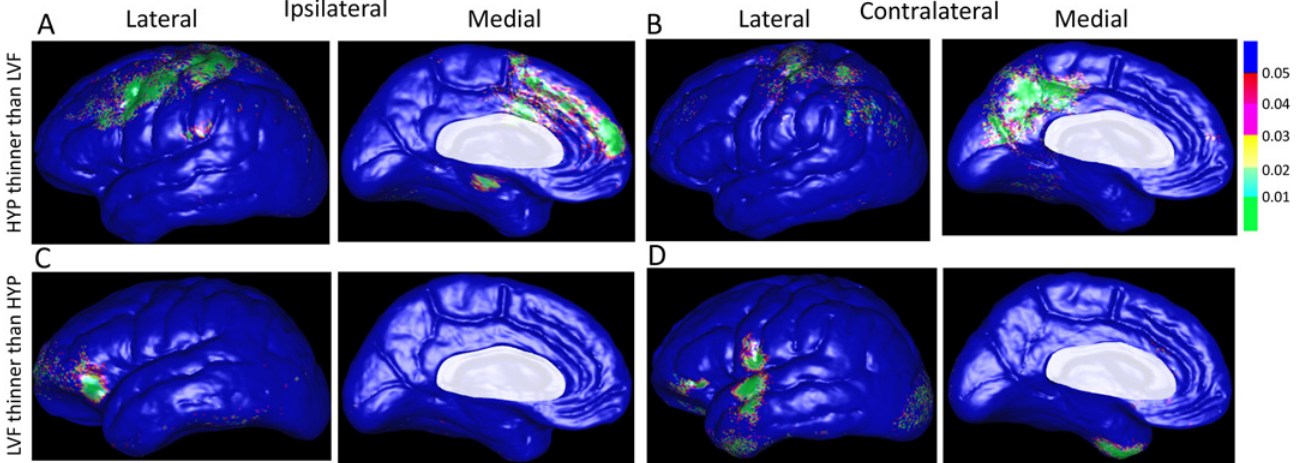
Fig 4. Color-coded P-maps of the lateral and medial surface of the cerebral hemisphere ipsilateral (A) and contralateral (B) to the SOZ depicting areas with a significant reduction in cortical thickness in relation to depth EEG seizure onset pattern and epilepsy duration after controlling for age and gender. Top row illustrates sites of significantly reduced gray matter thickness per year of epilepsy in patients with HYP onset seizures compared to those with LVF onset seizures, whereas bottom row reflects areas with reduced thickness in patients with LVF onset seizures with respect to those with HYP onset seizures. Permutation test correcting for multiple comparisons was significant (ipsilateral: p = 0.037; contralateral: p = 0.036). Areas masked in white (i.e., corpus callosum, diencephalon) were not included in this analysis. Color-coded p-value scale in upper right corner of the figure.